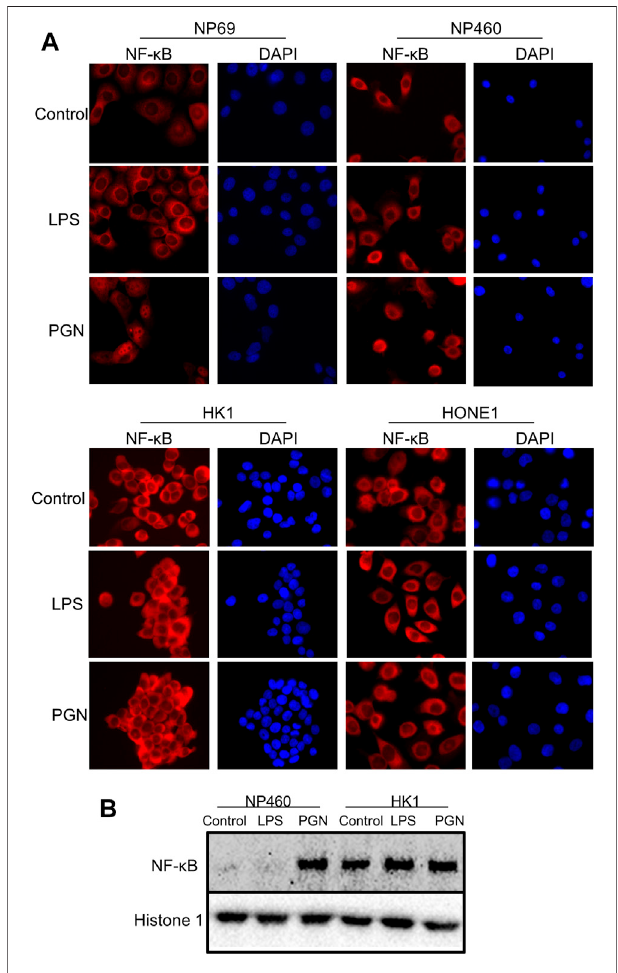
FIGURE 3 | Differential NF- κ B activation in normal and tumor cells. (A) Immuno fl uorescence analysis of activated, nuclear NF- κ B (p65) fraction in NNEcelllinesNP69andNP460,versusNPCcelllinesHONE1andHK1,upon exposuretoeither10 μ g/mlLPSor10 μ g/mlPGNfor2hours.Cellnuclei were visualized by DAPI. (B) Western blot analysis of nuclear NF- κ B fractions in the NP460 and HK1, treated with LPS and PGN as previously mentioned.